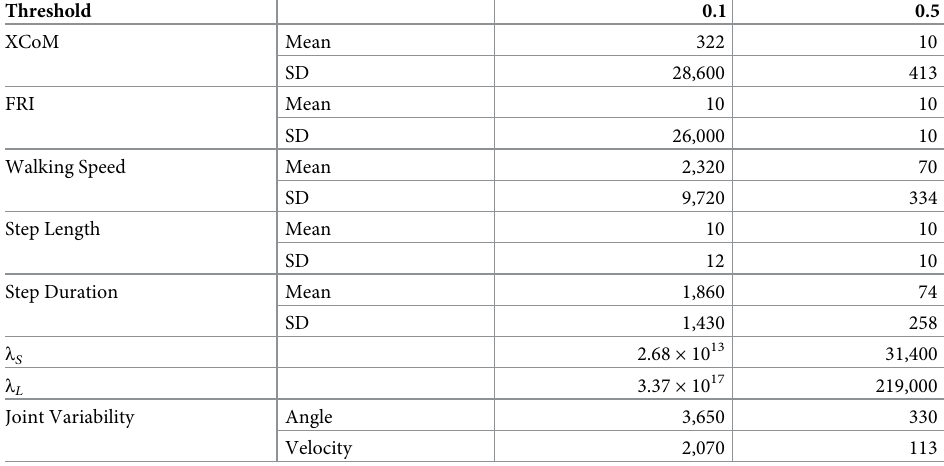
Table 4. Estimated number of steps required for 90% of the brute force metric values to be within 0.1 or 0.5 nor- malized units of the Markov chain metric